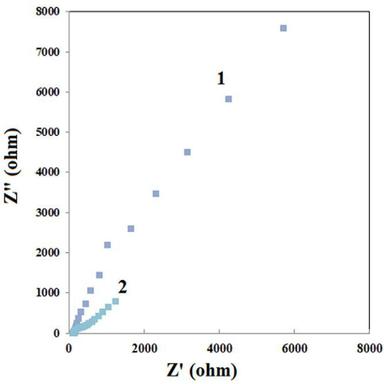
The Nyquist plots of bare CPE (1) and GO-imi- (CH2)2-NH2 modified CPE (2) in in 0.005 M k3Fe(CN)3 in open circuit potential (OCP).